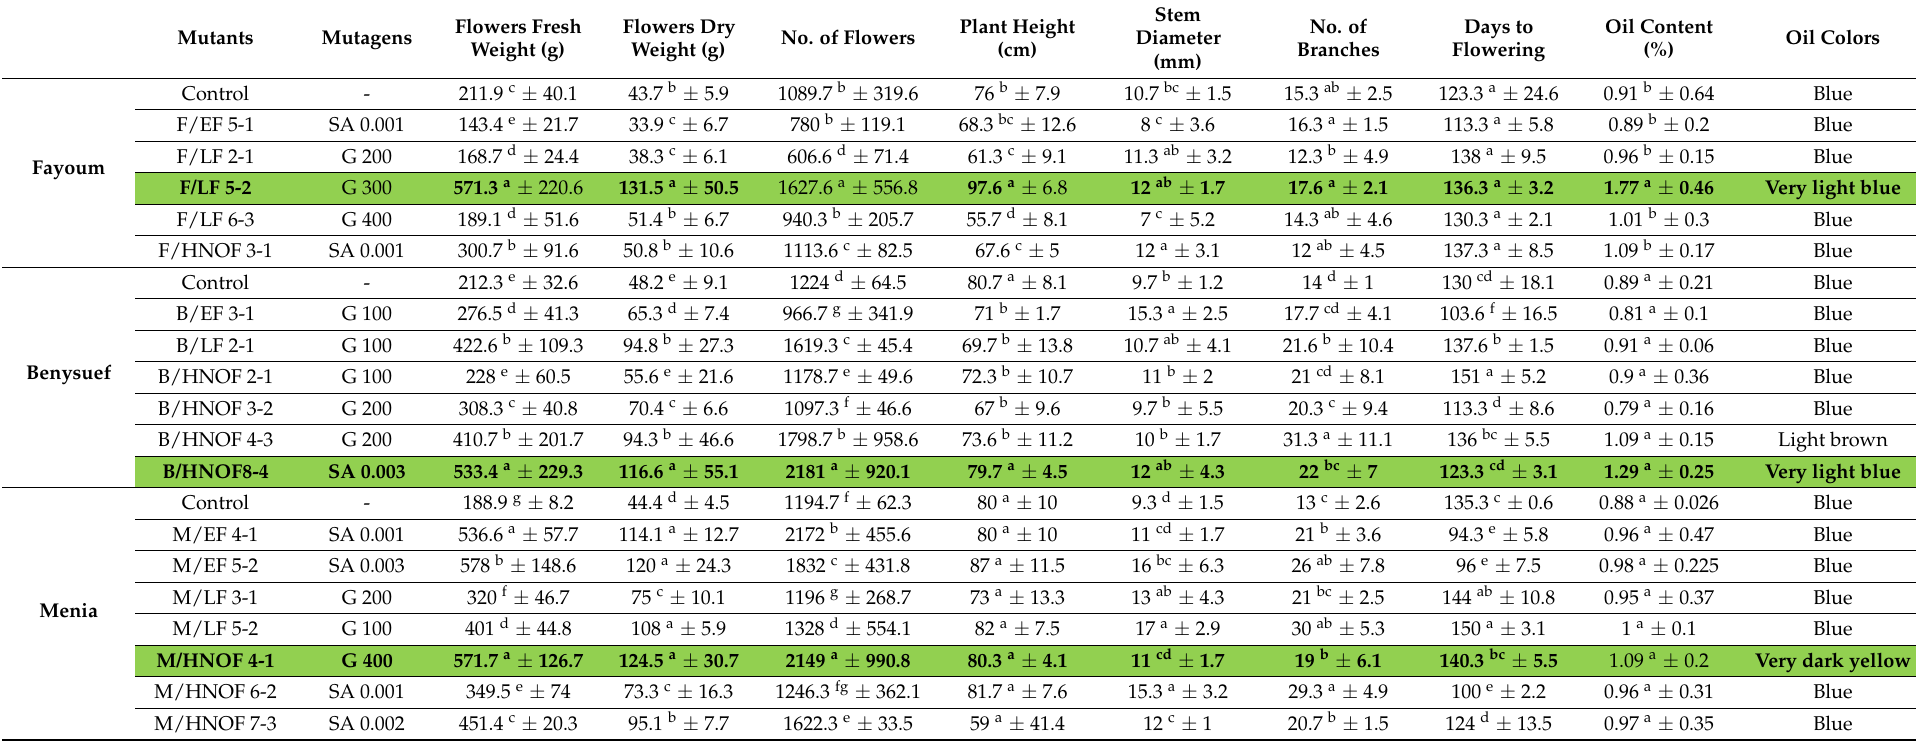
Table 2. Mean performance of morphological features, oil content and oil colors for selected M 3 mutants of German chamomile populations.